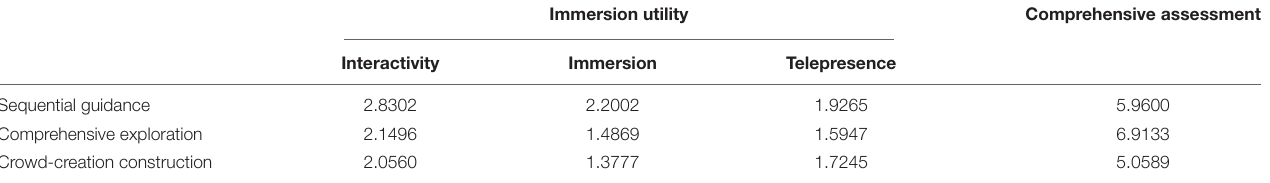
TABLE 2 | Immersion utility.